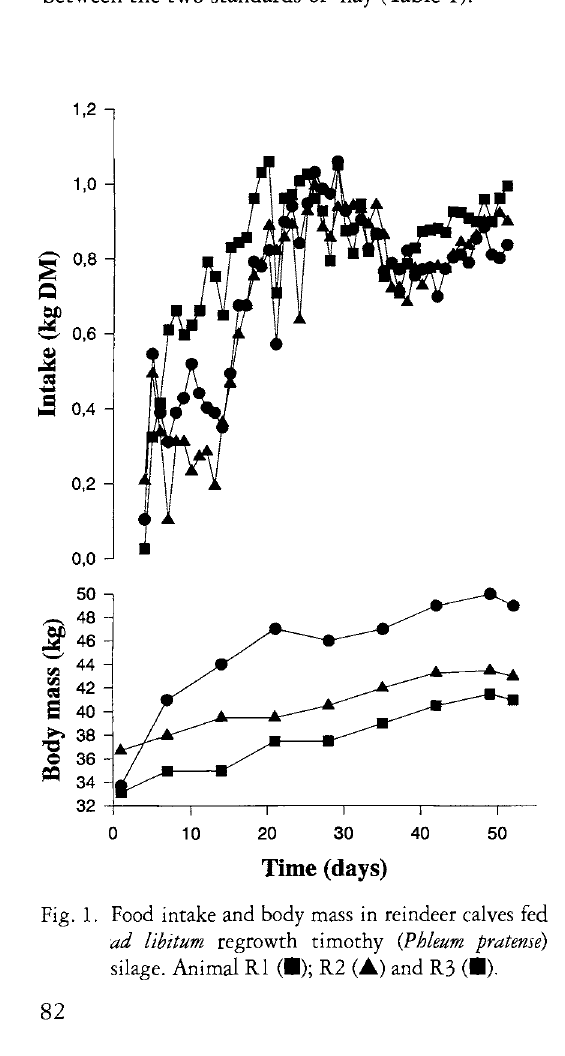
Fig. 2. Median in vitro dry matter digestibility (% IVDMD) of pure cellulose (Whatman no. 1 filter paper) in rumen fluid from reindeer calves fed ad libitum regrowth timothy (Phleum pratense)